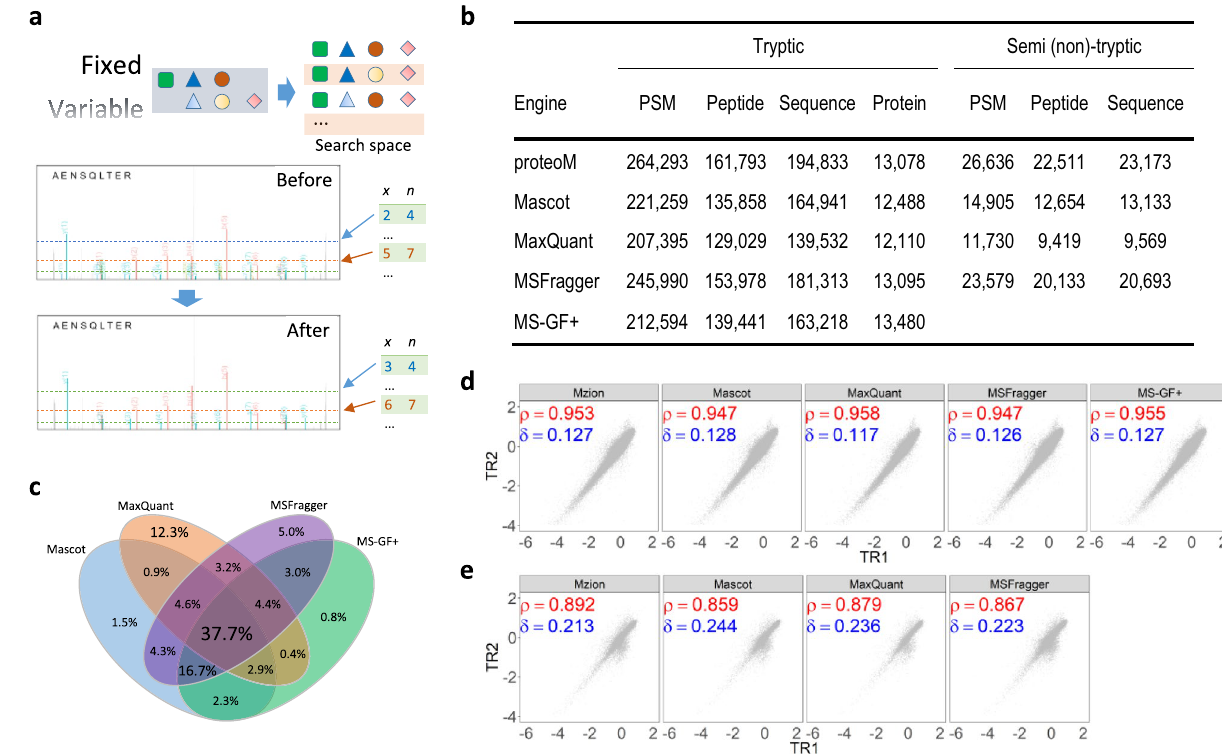
Figure 2. Performance of Mzion on the global dataset JHU_G2. ( a ) The workflow. ( b ) Summary in peptide and protein identifications. Peptide: without modification information in the literal of a peptide representation; Sequence, with applicable modification information in the literal. ( c ) Significant PSMs by four previously established search engines. ( d,e ) Pearson correlation (ρ) and Manhattan distance (δ) of log2FC. ( d ) tryptic; ( e )